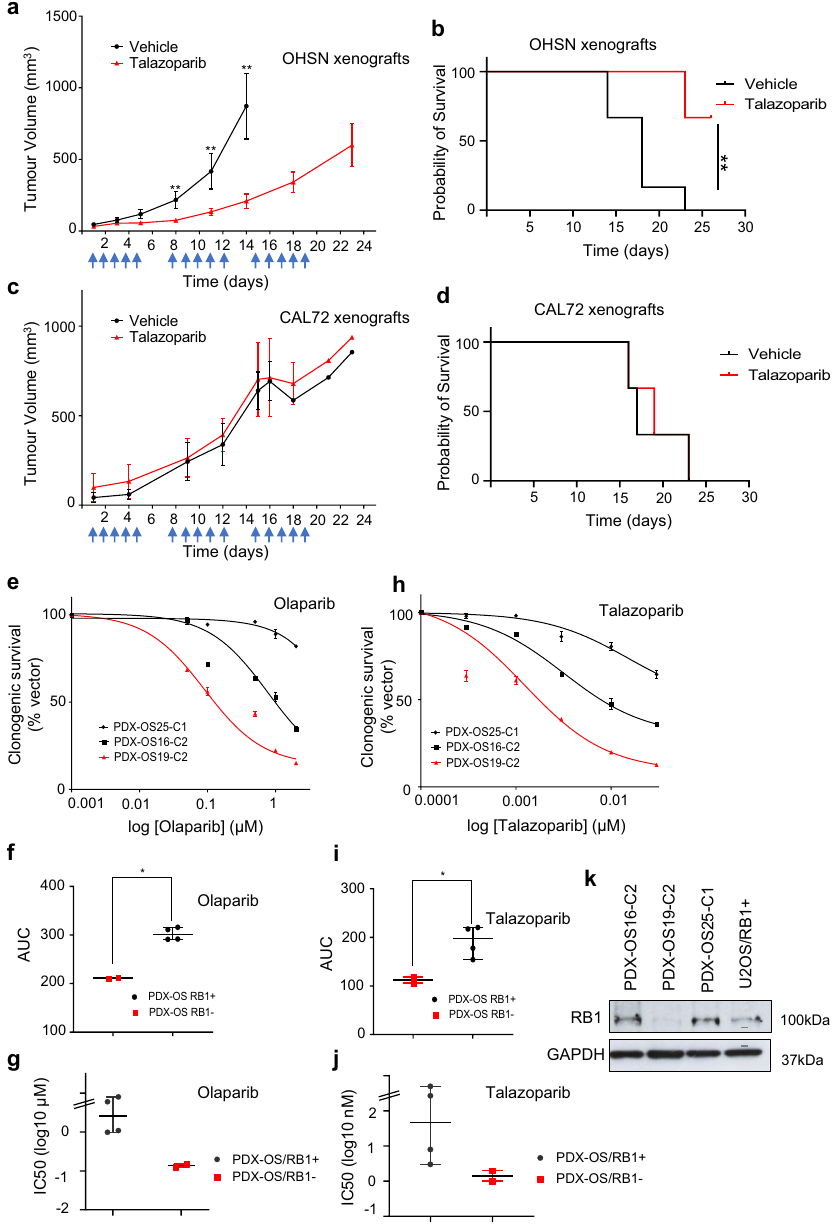
Fig. 9 Selective single-agent PARPi sensitivity in in vivo xenograft and patient-near 2D models. a – d Tumour response to single-agent PARPi treatment. NRG (NOD.Cg-Rag1tm1Mom Il2rgtm1Wjl/Szj) mice carrying OHSN or CAL72 tumour xenografts were treated daily ( fi ve times per week) with the PARPi talazoparib at 0.33 mg/kg, or vehicle for 3 weeks. a , c Tumour volumes over time, measured at the indicated time points. Arrows indicate dosing schedule of PARPi or vehicle. Data points represent mean ± SEM for n = 6 (OHSN) or n = 3 (CAL72) mice per treatment arm. p ( a ) day 8 = 0.0087**, day 11 p = 0.009** and day 14 p = 0.0022** calculated using a two-sided unpaired Student ’ s t test, p ( c ) day 8 = 0.7 ns , day 11 p > 0.99 ns and day 14 p > 0.99 ns calculated using a two-sided unpaired Student ’ s t test. b , d Kaplan – Meier survival analysis of mice assessed in a and c . p ( b ) = 0.0027**, p ( d ) = 0.8584 ns , calculated using a log rank (Mantel – Cox) test. e – j PARP inhibitor response in patient-near 2D models assessed using clonogenic survival. Concentration- response curves ( e , h ), depicting results for RB1-defective (red) or RB1-normal (black) patient-near osteosarcoma models after treatment with olaparib, or talazoparib. Data re fl ect the mean ± SD of parallel duplicate wells for one of n = 2 biologically independent datasets. Scatter plots ( f , i ) summarising AUC values from n = 2 biologically independent datasets involving olaparib, p (f) = 0.012*, or talazoparib, p ( i ) = 0.0114*, calculated using a two-tailed Mann – Whitney test. Bars depict median and ±95% CI. Scatter plots ( g , j ) summarising IC50 values deduced from dose response data from n = 2 biologically independent datasets. Bars depict median ±95% CI. Immunoblot analysis ( k ) assessing the expression of RB1 in osteosarcoma patient-near cell models. GAPDH was used as loading control. Source data are provided as a Source Data fi